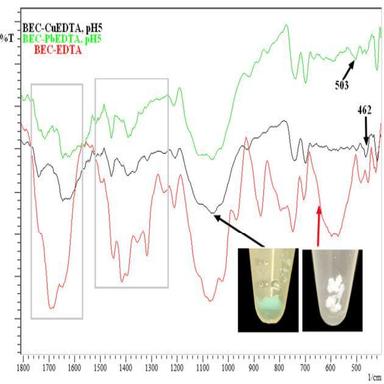
FTIR spectra of BEC-EDTA as recuperated, BEC-Pb-EDTA and BEC-Cu-EDTA